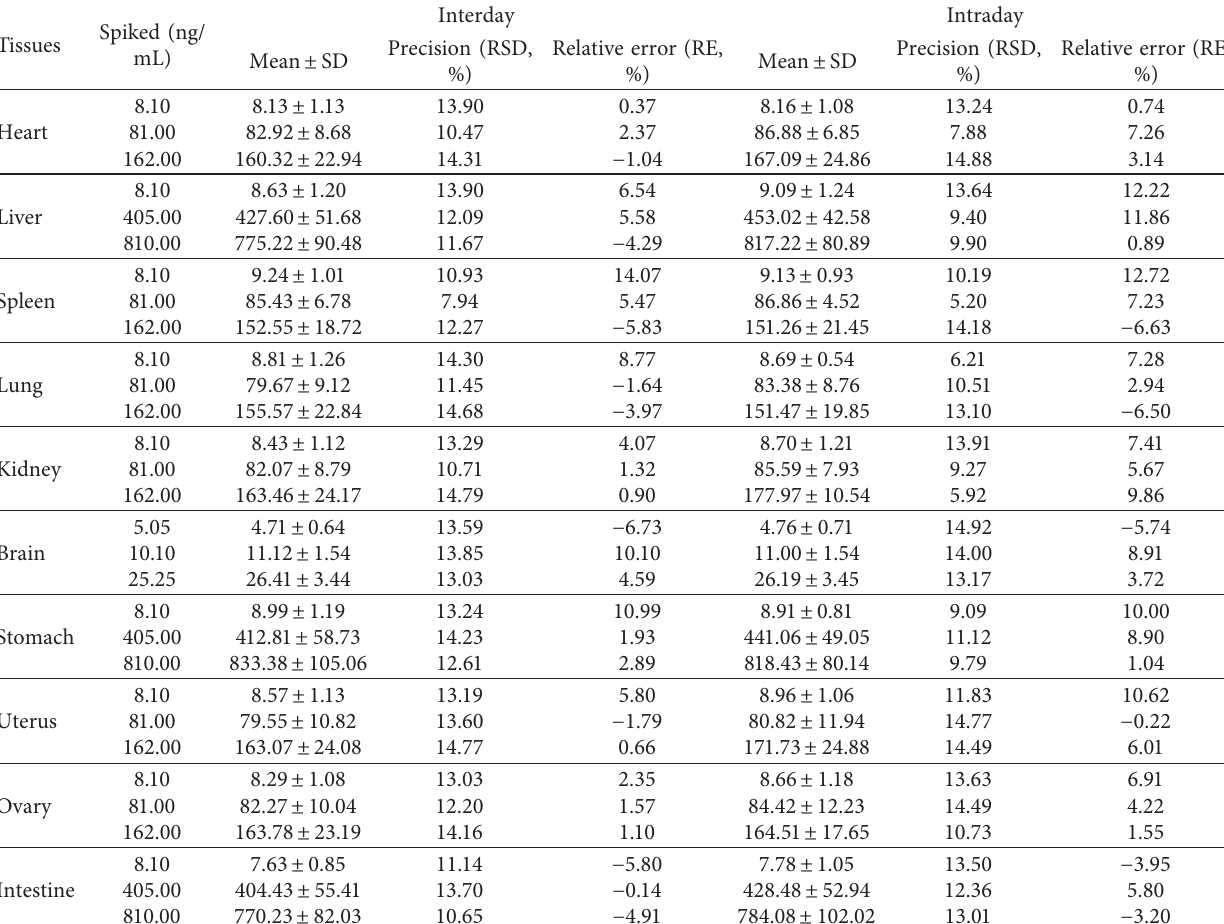
Table 8: Interday and intraday precision and accuracy data for assays of naringenin in different tissues ( n � 6). Spiked (ng/ Tissues